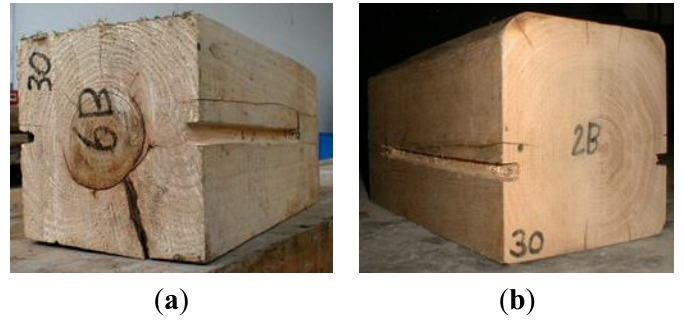
Figure 2. ( a ) Softwood prism (fir); ( b ) hardwood prism